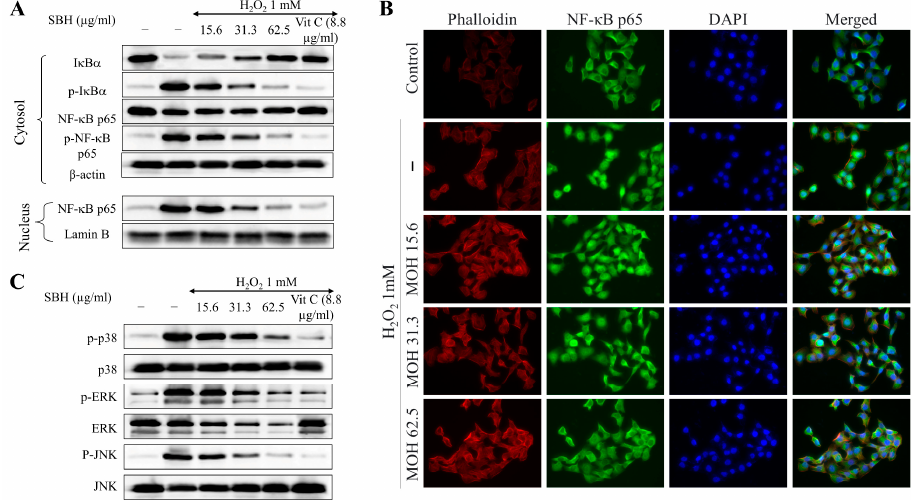
Figure 7. Effects of SBH in suppressing NF- κ B and MAPK signaling in H 2 O 2 -induced Vero cells. Effects of SBH on NF- κ B signaling pathway analyzed by ( A ) Western blot analysis and ( B ) immunofluorescence analysis of NF- κ B p65 nuclear translocation; ( C ) Western blot analysis of key MAPK signaling molecules. Experiments were carried out in triplicate (n = 3) to ensure repeatability.